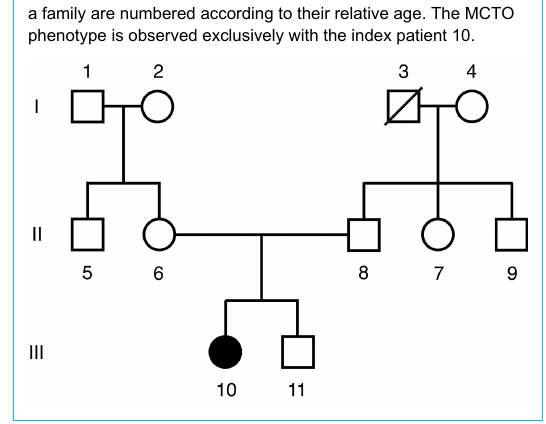
Figure 2: Pedigree of the patient’s family. Individual members of a family are numbered according to their relative age. The MCTO phenotype is observed exclusively with the index patient